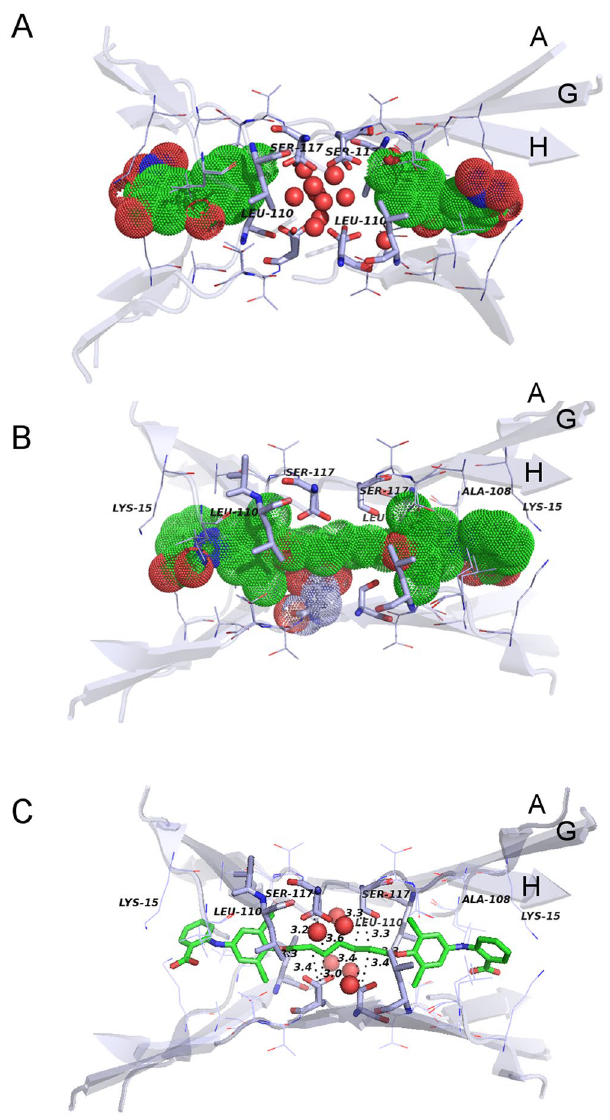
Figure 2. TTR binding sites in the presence of tolcapone and mds84. Wild type TTR binding sites occupied by tolcapone ( A ) and mds84 ( B ) with ligands shown as solvent accessible surfaces. For clarity, H 2 O oxygens are shown as spheres with 50% of the van der Waals radius. ( C ) Wild type TTR-mds84 complex with highlighted distances of the principal hydrophobic contacts between the ligand methylene linker and TTR atoms.